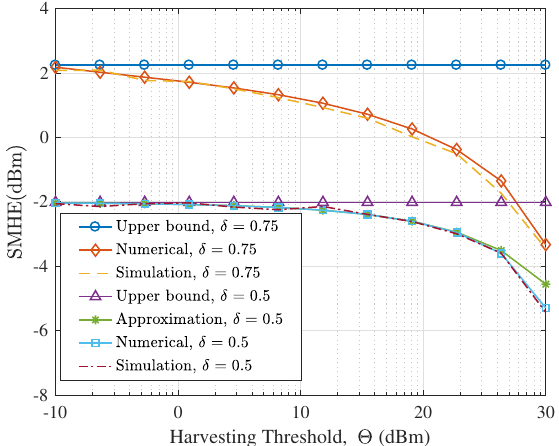
Figure 9. Spatial mean harvestable energy for LSWN-noIC with λ t = 0.0001, α = 4, η a = 1 and P et = 30 dBm.